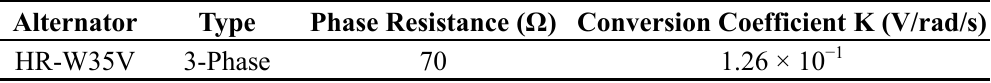
Table 4. Electric characteristics of the